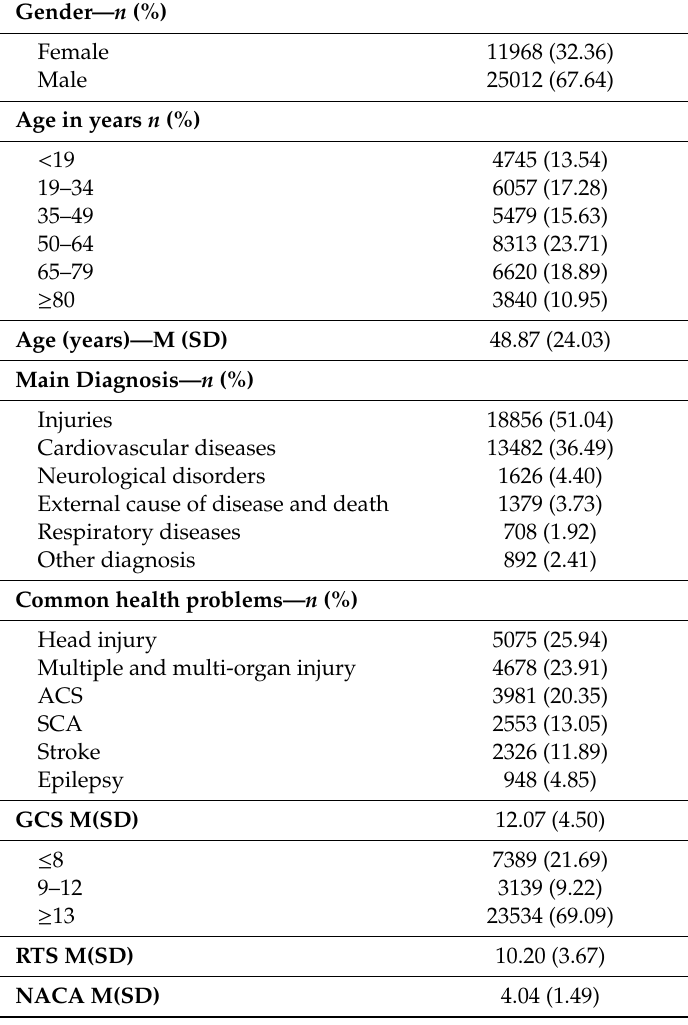
Table 1. Patient characteristics and clinical